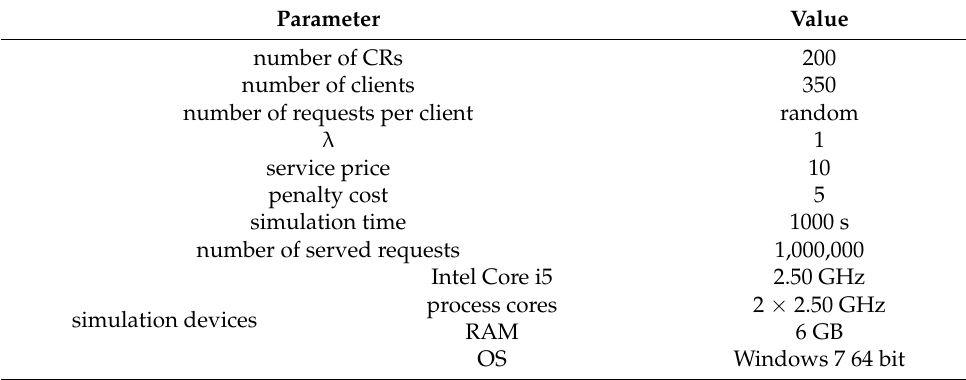
Table 1. Simulation